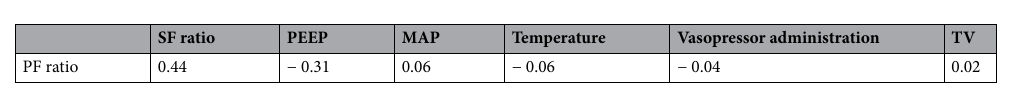
Table 1. Correlation coefficients between PF ratios and variables. Correlation coefficients between measured PF ratios and the six other measured variables (SpO 2 /FiO 2 = SF ratio, PEEP, MAP, Temperature, Vasopressor Administration and TV) were performed. The variable with the strongest correlation coefficient (r) was chosen for the 3-feature model. PF ratio PaO 2 /FiO 2 , SF ratio SpO 2 /FiO 2 , TV tidal volume, PEEP positive end- expiratory pressure, MAP mean arterial